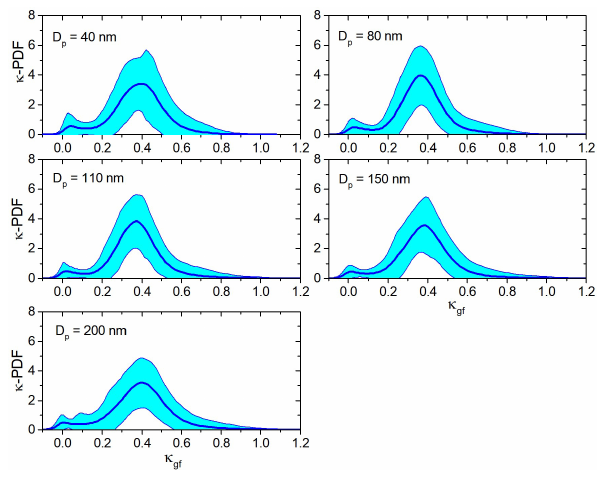
Figure 3. Mean probability density functions of κ and their standard deviations (shaded areas) for 40, 80, 110, 150, and 200nm particles at the Xingtai site in May–June 2016, as derived from measured GF at 85% RH. Reprint with permission by Y. Wang et al.